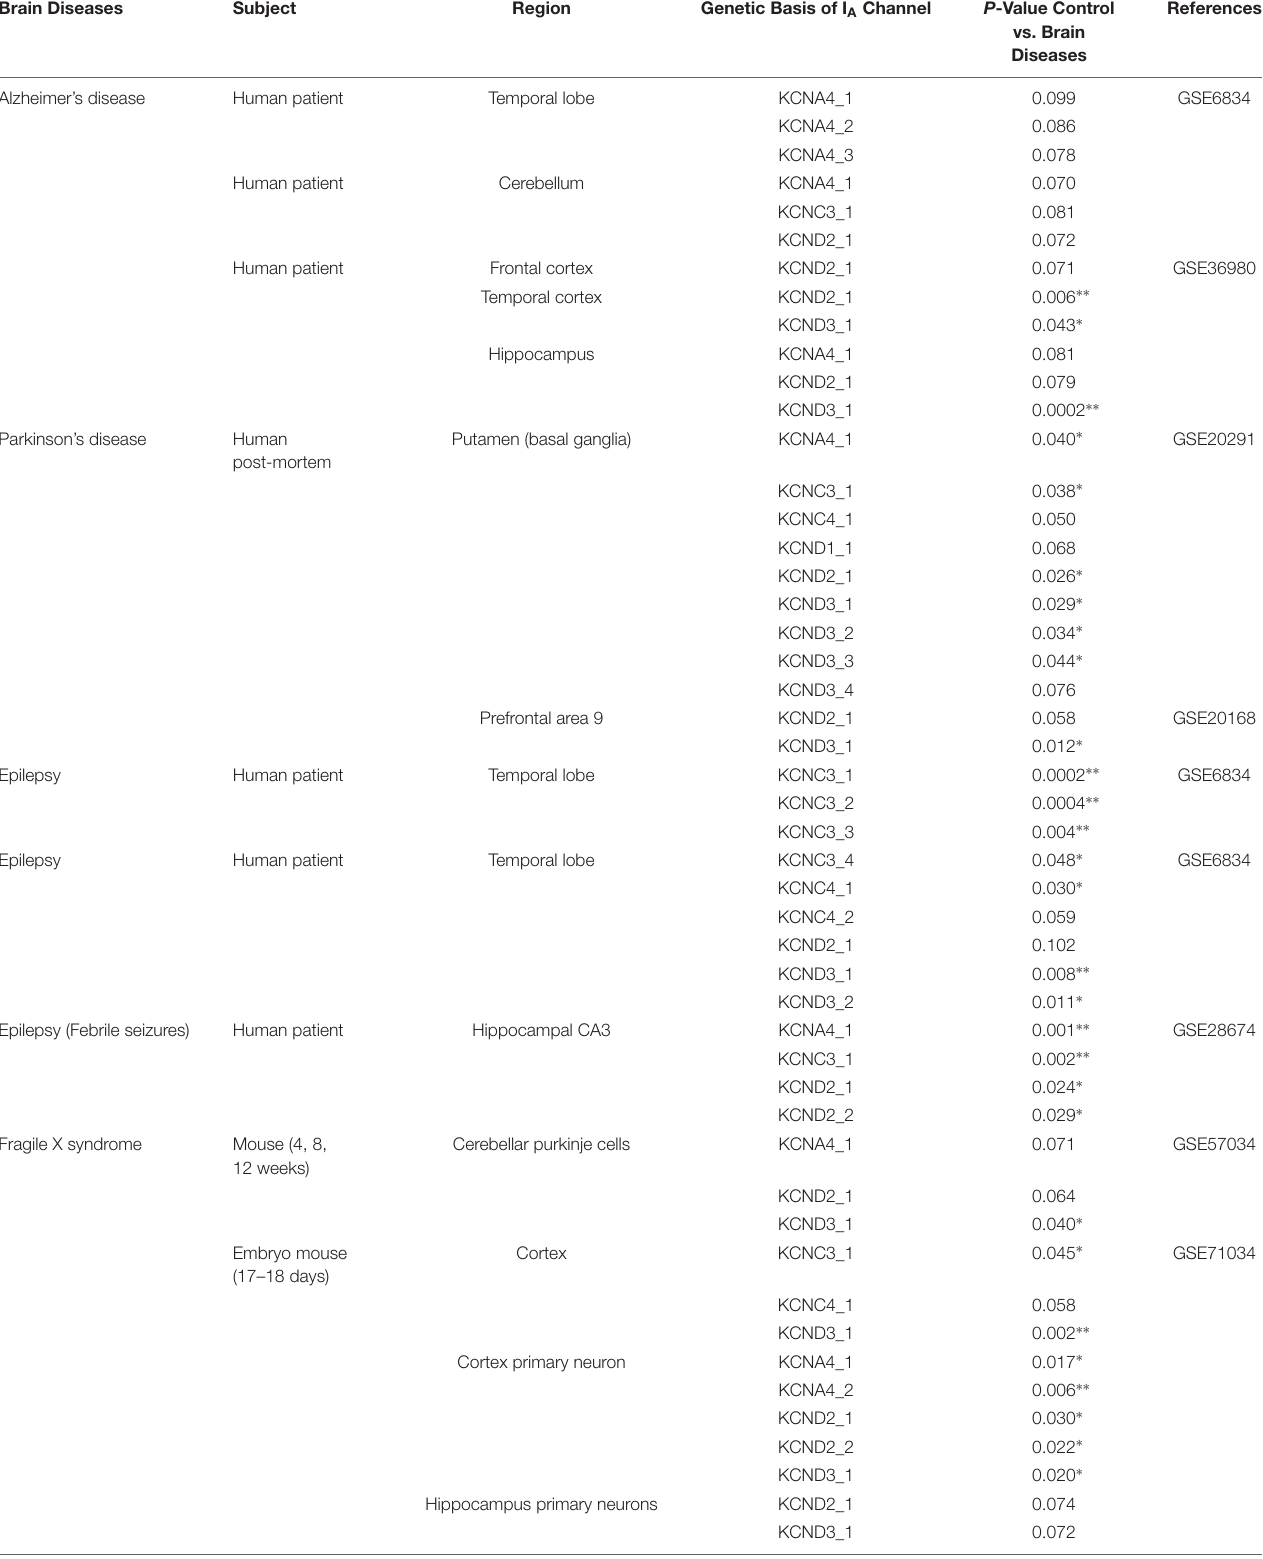
TABLE 3 | Effects of I A channel mRNA expression in brain